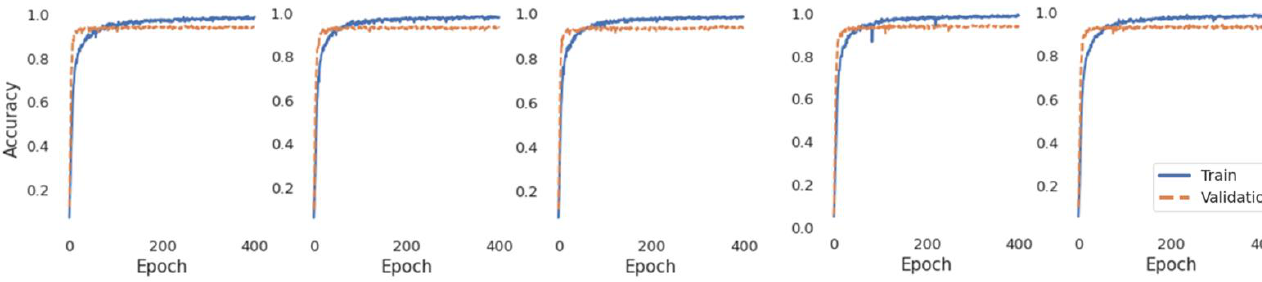
Figure 11. Example of training and validation curves when a model is trained five times.